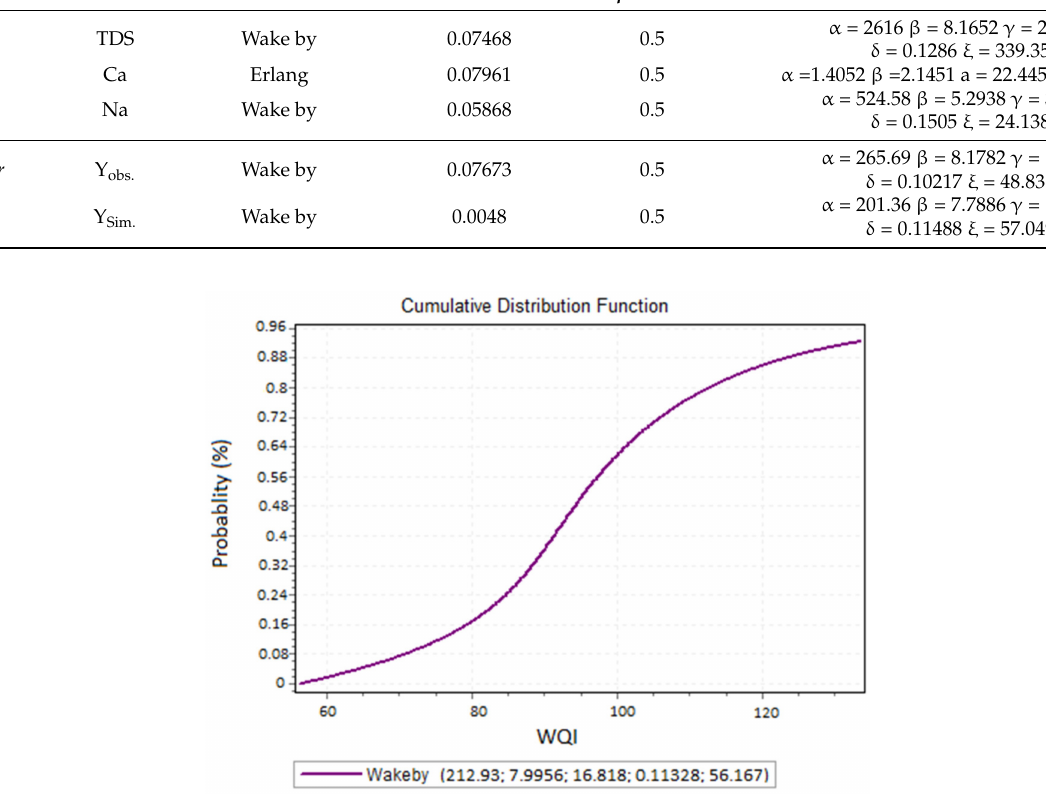
Figure 5. The cumulative density function for the WQI that was simulated by the ANN CGD training algorithm-based MLR